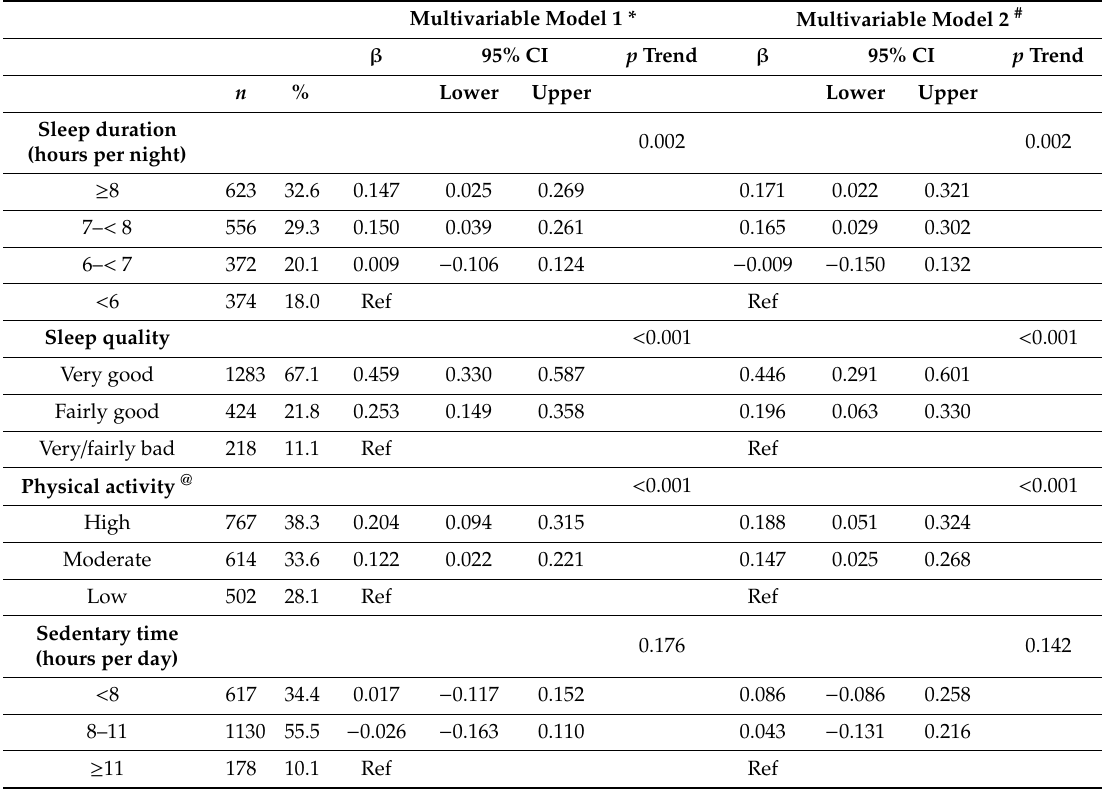
Table 2. Associations of sleep and physical activity related behaviours with the total positive mental health